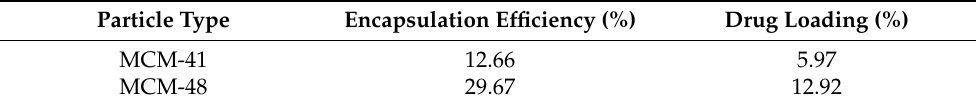
Table 1. Drug loading and encapsulation efficiency values determined by the HPLC method.